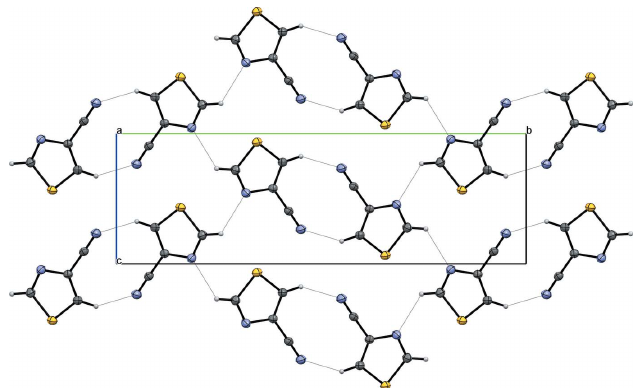
Figure 2 Packing diagram for the title compound along the a axis. Ellipsoids are drawn at the 30% probability level. Hydrogen bonds are shown as dotted